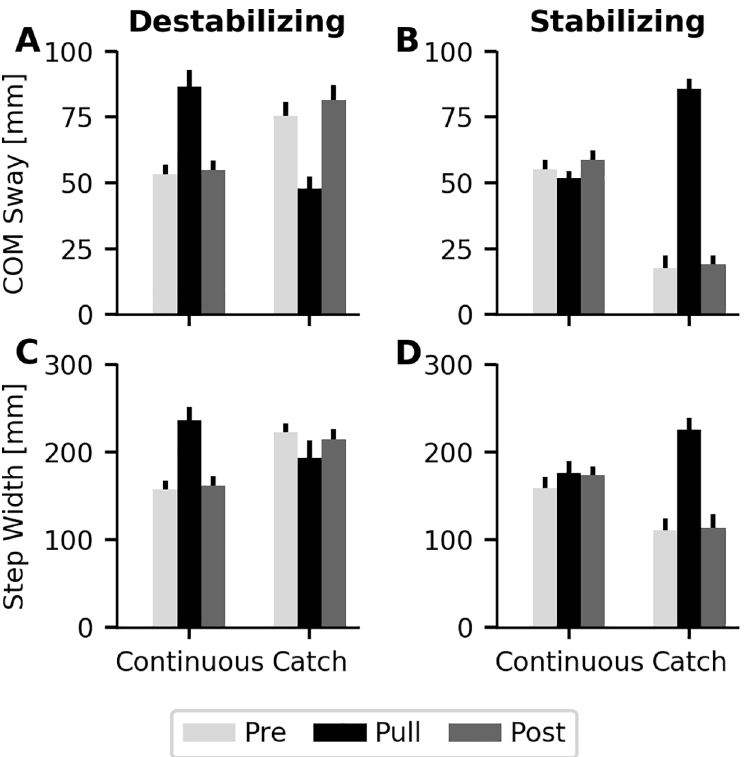
Fig 7. Catch trials for 5% BW and no handrail hold condition. Average catch trial response from the destabilizing (A and C) and stabilizing (B and D) perturbation trials. Catch trials during pre and post blocks applied forces for a single cycle, while catch trials in the perturbation block removed applied forces for a single cycle. Destabilizing forces demonstrated an additive effect with prolonged step-by-step perturbations producing larger changes compared to single cycle perturbations. Single cycle stabilizing perturbations produced larger changes compared to prolonged step- by-step perturbations likely due to the perturbation of COM movement opposite to the direction of movement. Removal of forces in the perturbation block demonstrates retained changes in both COM sway and step width for both perturbation types, indicating participants did adapt to the applied forces.